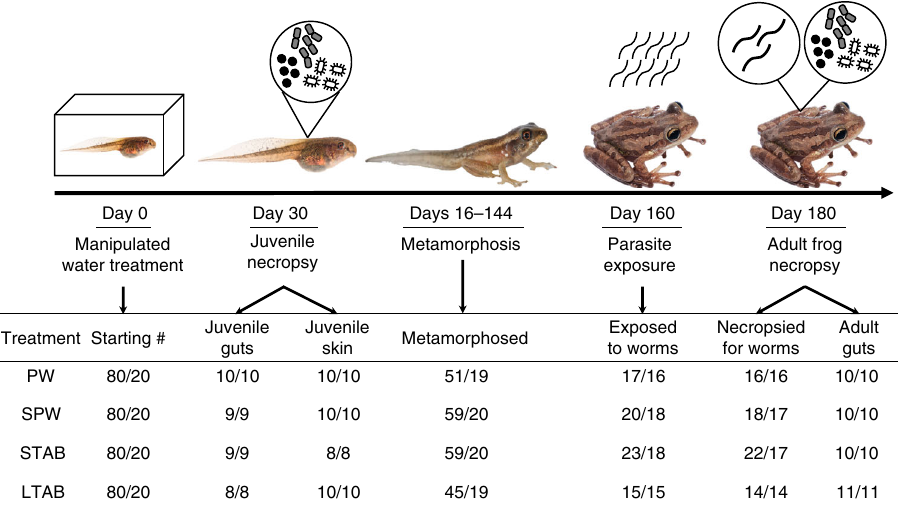
Fig. 1 Testing the effects of early-life disruption of the microbiota on later-life resistance to infections. Juveniles were reared in one of four water treatments: pond water control (PW), sterile pond water only (SPW), sterile pond water and short-term antibiotics (STAB), or sterile pond water and long- term antibiotics (LTAB). Adult frogs were exposed to A. hamatospicula worms to quantify the lasting effect of the manipulated microbiota of juveniles on adult resistance to infections. Numbers represent sample sizes (i.e., number of individuals/number of tanks) for each time point. Photos by Mark Effect of water treatment on host resistance . Adult resistance to